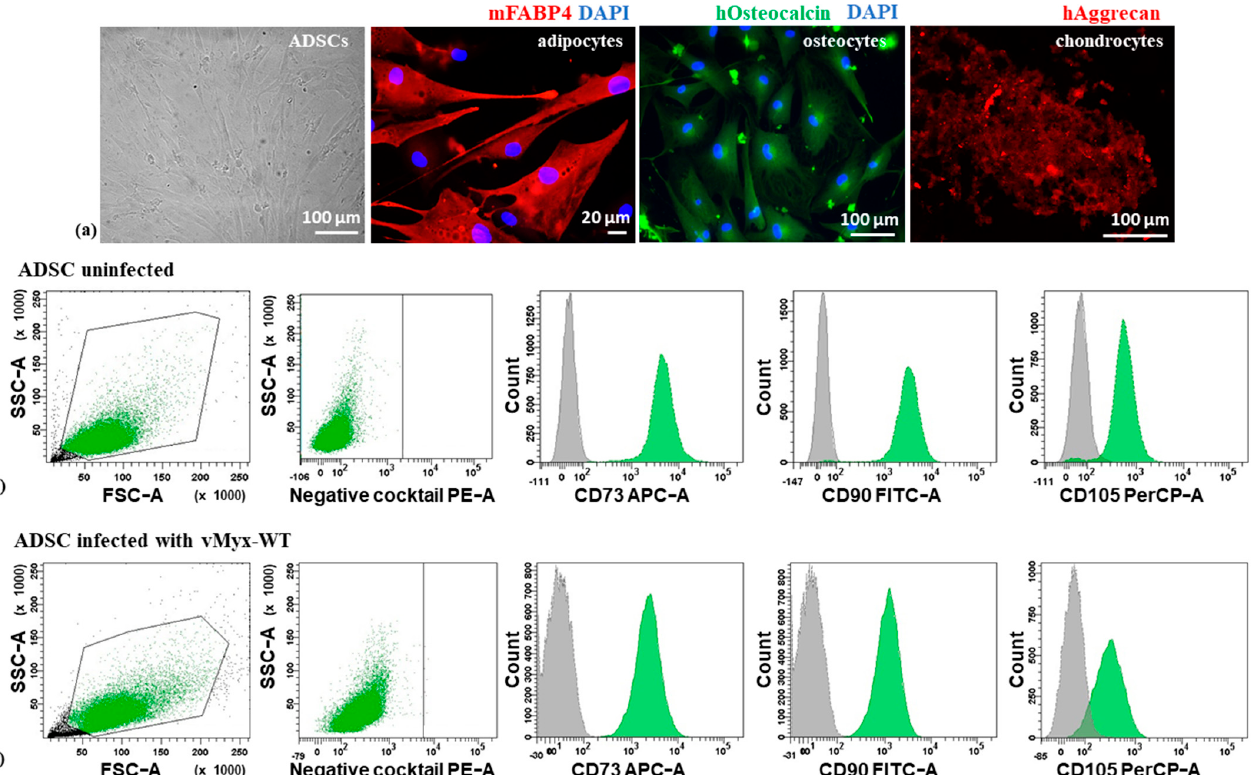
Figure 1. Characterization of adipose tissue-derived stem cell ADSC ( a ) morphology (far left) and differentiation of ADSCs into adipocytes (anti-mFABP4 antibody), osteocytes (anti-hOsteocalcin antibody) and chondrocytes (anti-hAggrecan antibody, red); DAPI-counterstained nuclei (magn. 40×; scale bar = 20 μ m for adipocytes; magn. 20×; scale bar = 100 μ m for osteocytes and chondrocytes). Flow cytometry plots of uninfected ADSCs ( b ) or ADSCs infected ( c ) with vMyx-WT (MOI = 10) confirming the presence of CD73, CD90 and CD105 and the concomitant absence of CD11b, CD19, CD34, CD45 or HLA-DR markers; gray: isotype control; green: viable ADSCs. Gating parameters based on the signal of isotype IgG control probes.